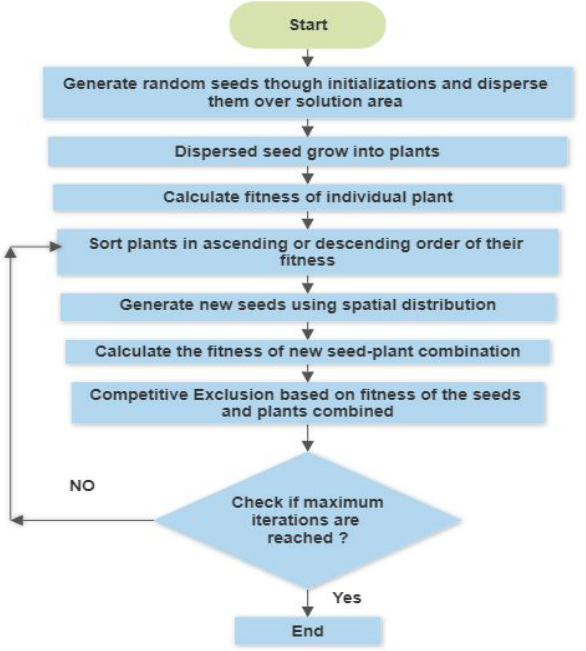
Figure 1. Invasive weed optimization (IWO) algorithm flow chart.